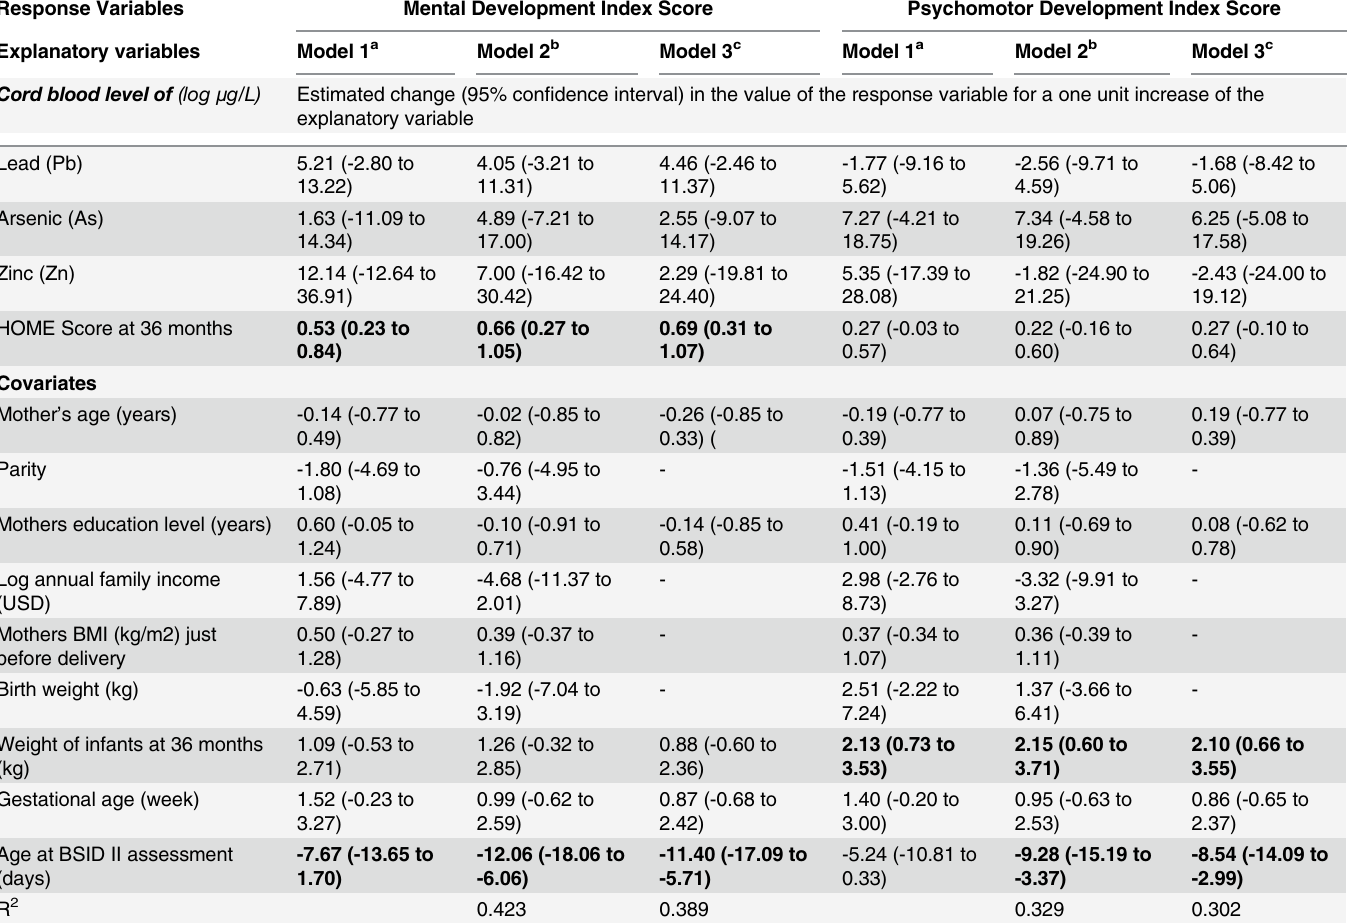
Table 2. Association of demographic and in utero chemical and home environmental variables with MDI and PDI scores of BSID II at 36 months from birth (n =